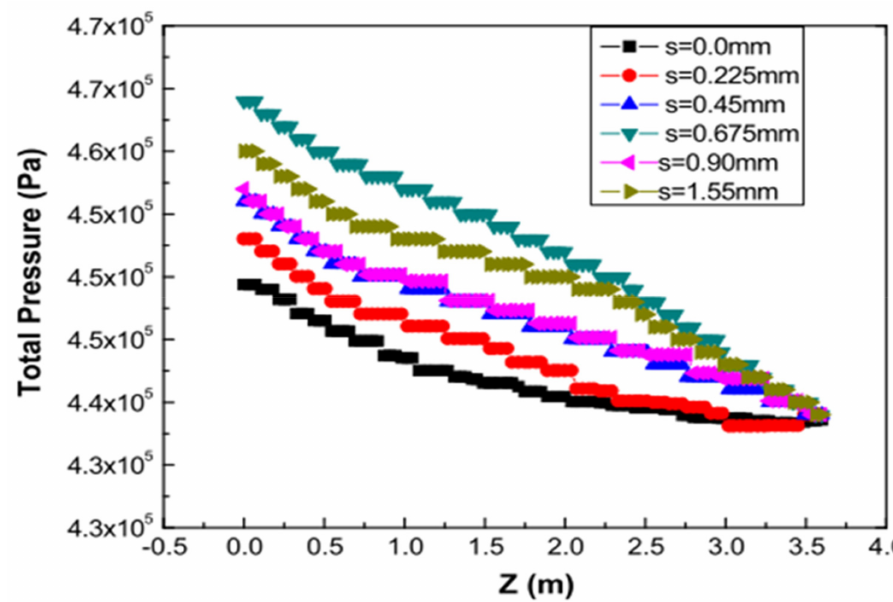
Figure 9. Variation of the pressure along the tube [27].